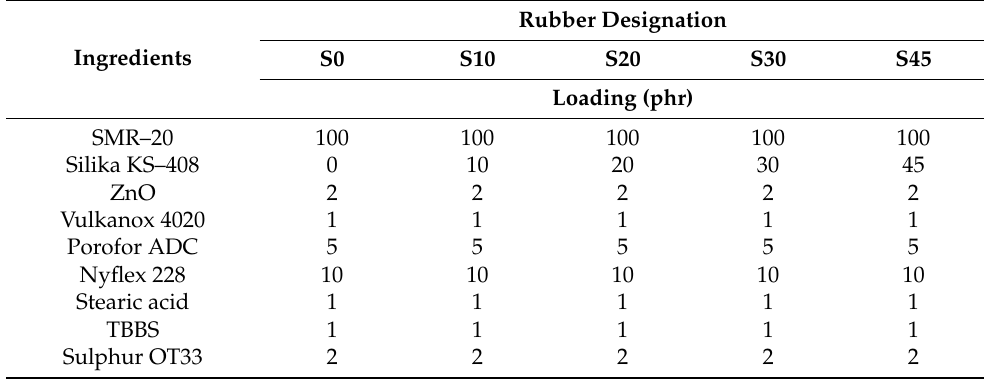
Table 1. Recipe of the investigated rubber